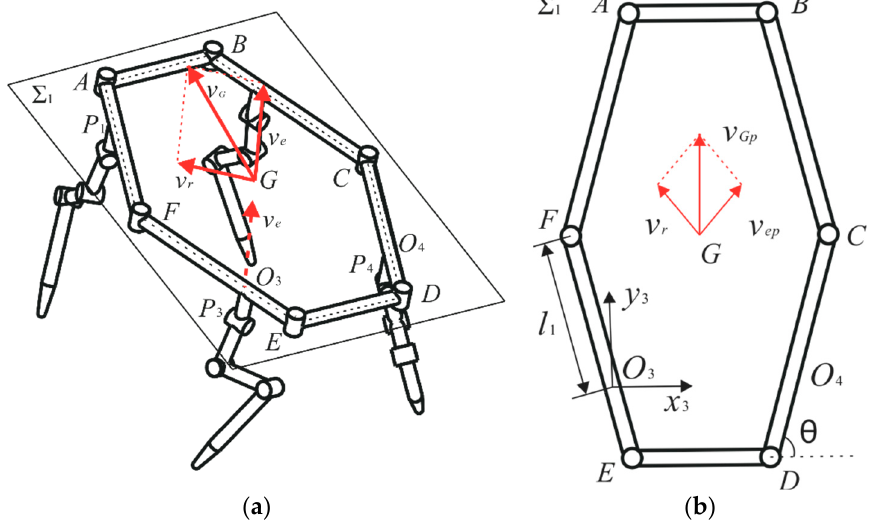
Figure 4. the velocity decomposition of the robot. ( a ) The velocity of the leg and its projection on the plane Σ 1 ; ( b ) The moving reference frame on the plane Σ 1 and the relative velocity.